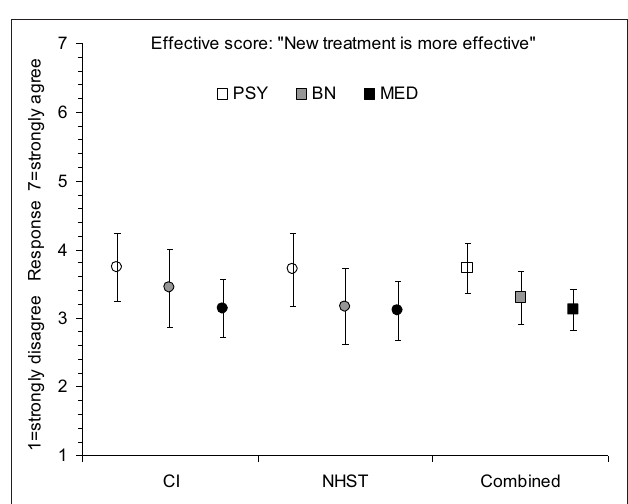
Figure 4 | Frequency histograms of Consistent scores in experiment 1. Responses indicate strength of agreement the two studies described in Figure 1 are consistent and do not conflict. Histograms are shown for the two NHST display formats combined, and the two CI formats combined – in each case for all three disciplines